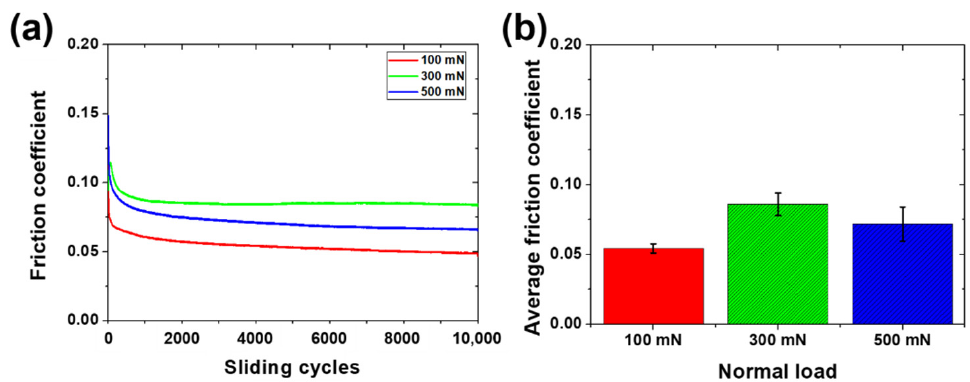
Figure 5. Friction characteristics of PDMS specimen under 100 mN, 300 mN, and 500 mN normal loads and 1 wt % surfactant–water lubricated condition during 10,000 cycles. ( a ) Variation values of friction coefficient with respect to number of sliding cycles, ( b ) Average values of friction coefficient.